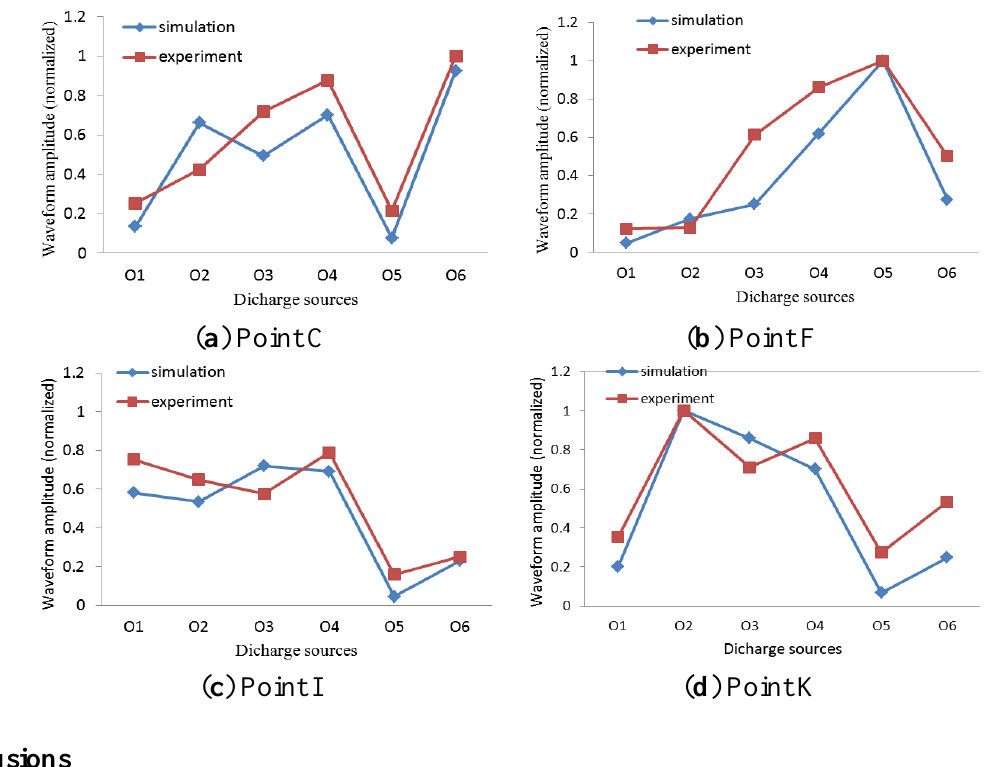
Figure 15. Comparison between the results of test verification and simulation